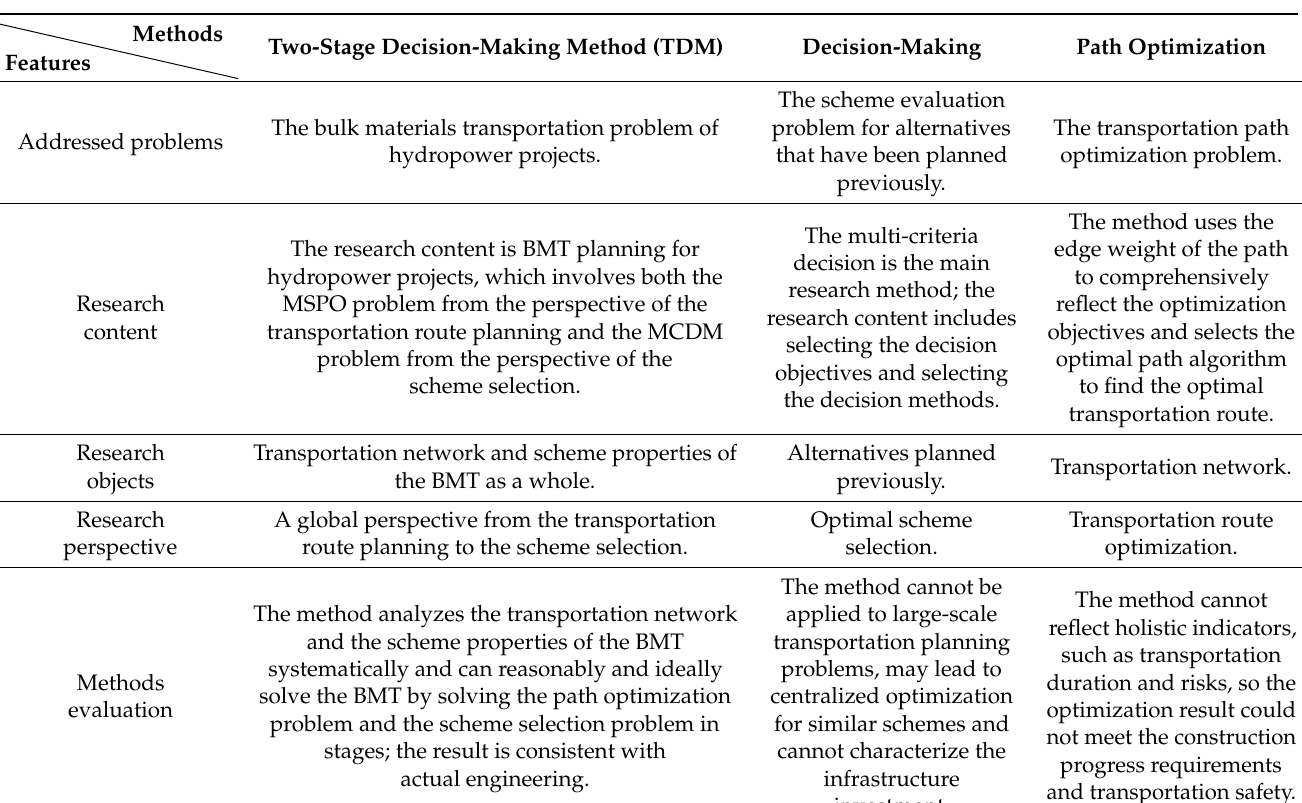
Table 1. Comparative information between the TDM and the traditional